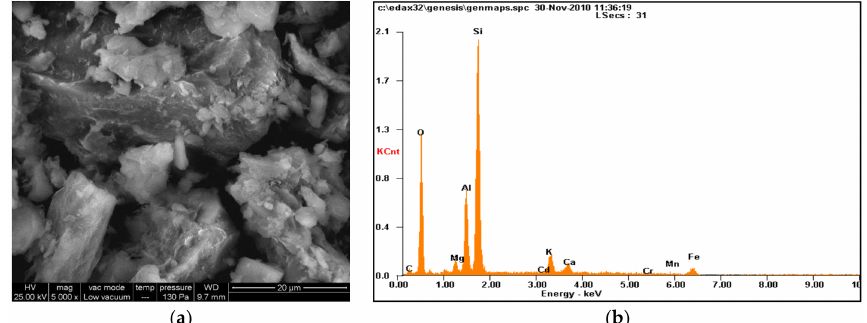
Figure 3. Scanning electron micrograph of IS-65 soil particle at 20 µ m ( a ) and corresponding EDS spectrum ( b ).